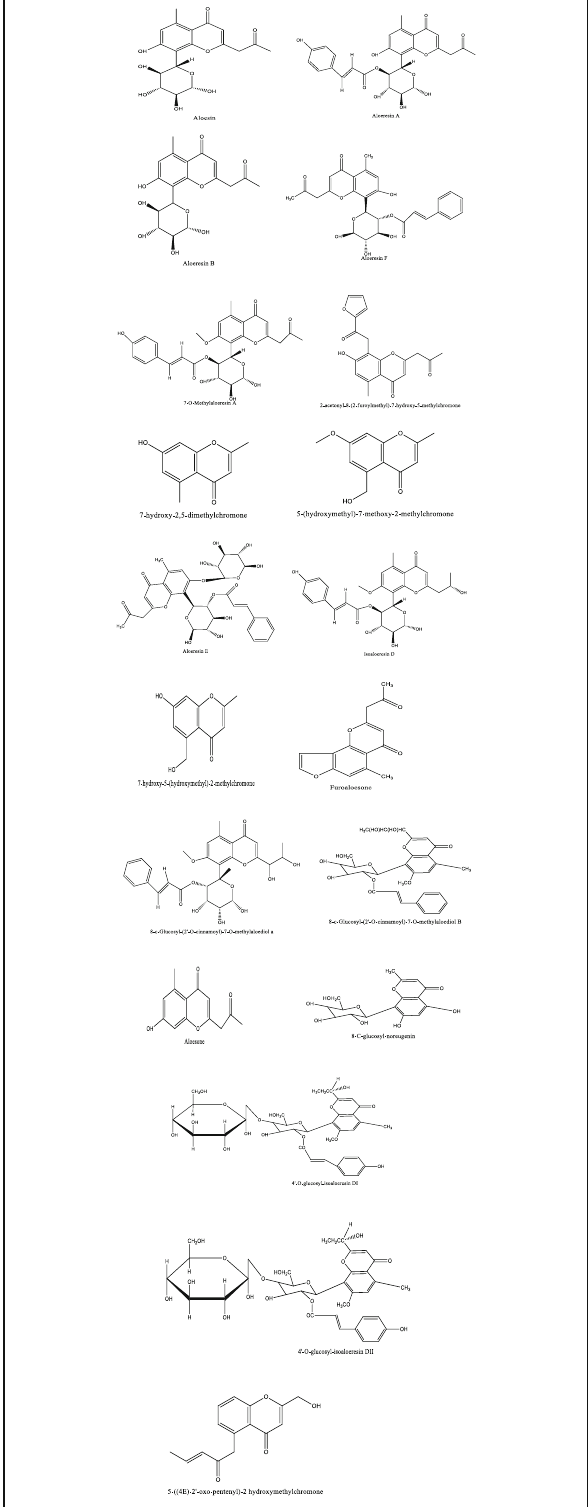
Fig. 1 Chemical structures of chromones isolated from A. vera and A.